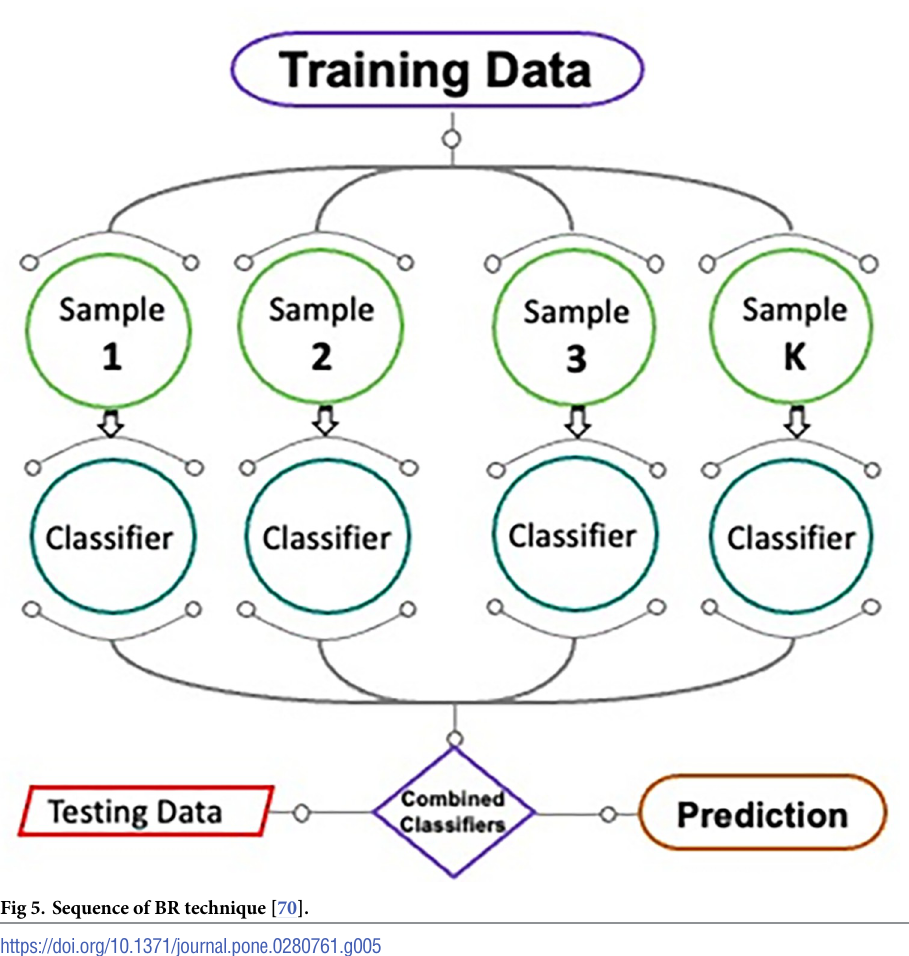
Fig 5. Sequence of BR technique